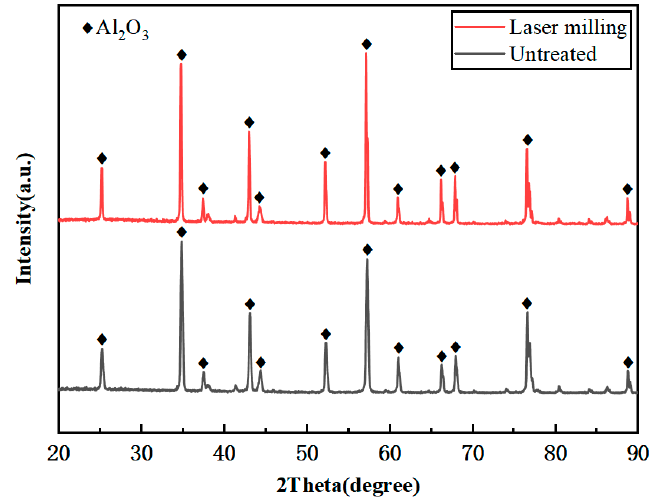
Figure 11. XRD results of specimens before and after laser milling.